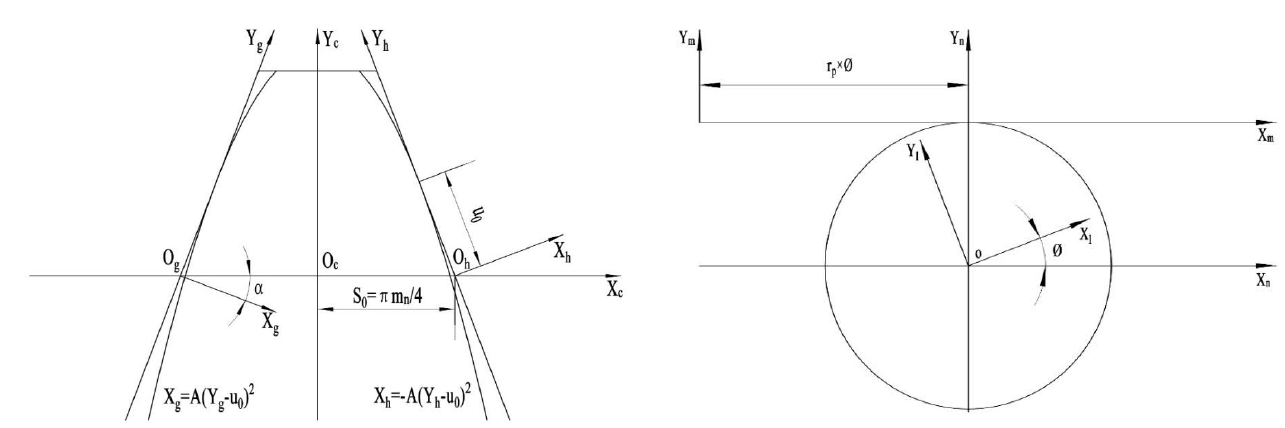
Figure 3. The coordinate conversion between S m and S n and S n and S 1